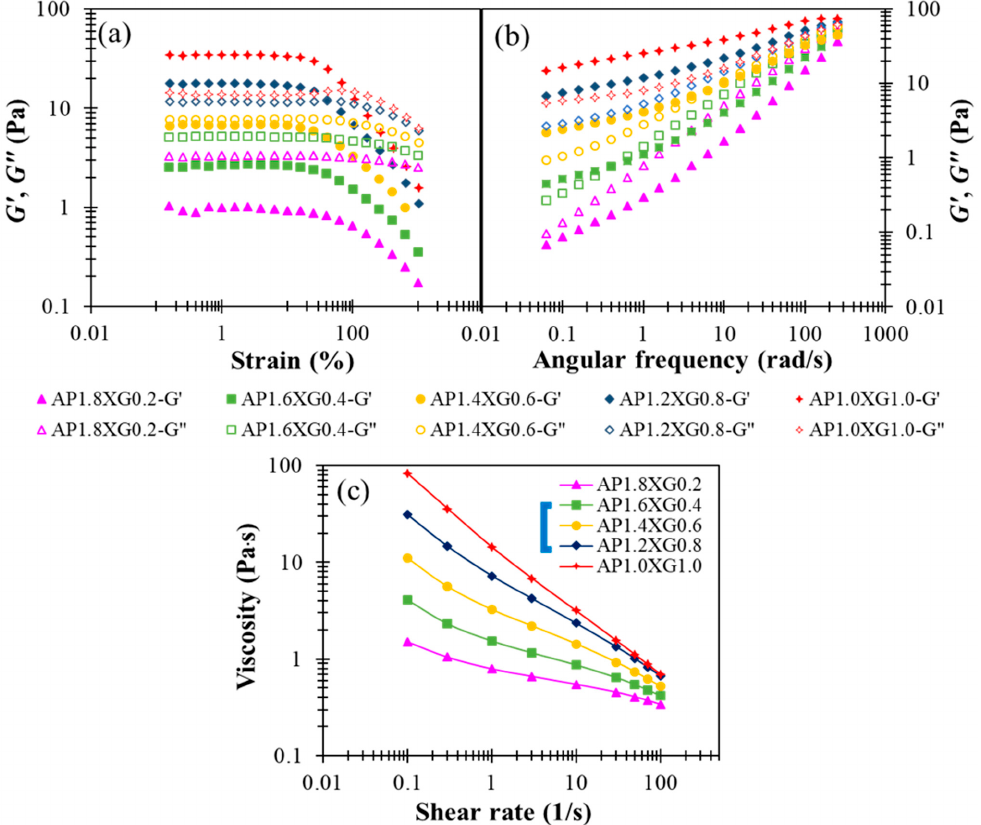
Figure 7. The modification effect of XG with regards to shear storage modulus (G’) and shear loss (G”) modulus profiles (G”) modulus profiles on AP-based DFMs under the designated AP-XC composite constraint of 2%: on AP-based DFMs under the designated AP-XC composite constraint of 2%: ( a ) strain sweep of AP-XG composite con- tained DFMs, ( b ) frequency sweep of AP-XG composite contained DFMs, and ( c ) the steady-state viscosity as a function ( a ) strain sweep of AP-XG composite contained DFMs, ( b ) frequency sweep of AP-XG composite of shear rate for various AP-XG composite contained DFMs. contained DFMs, and ( c ) the steady-state viscosity as a function of shear rate for various AP-XG composite contained